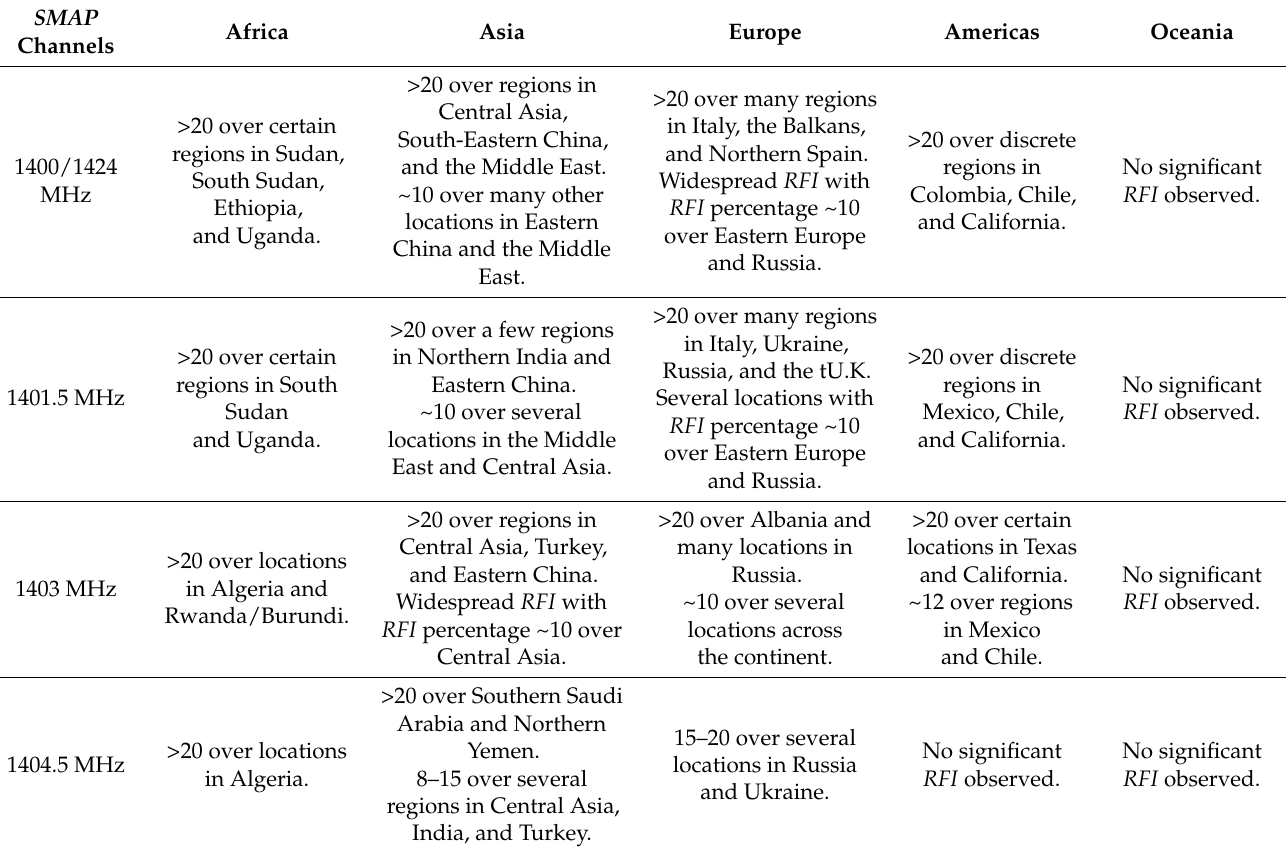
Table 2. RFI percentages (% RFI ch ) in SMAP channels over different